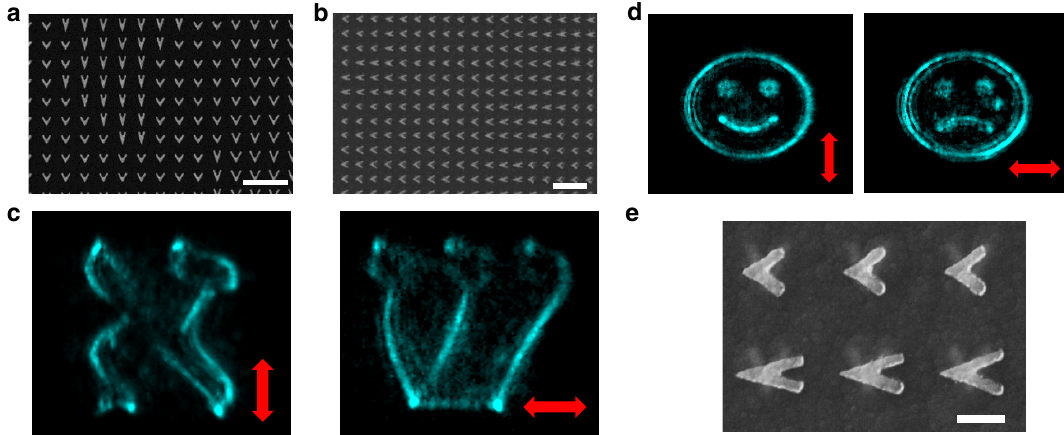
Figure 3 | Nonlinear metamaterial holograms. Scanning electron microscopy (SEM) images of the first ( a ) and the second layer ( b ) of a 3D nonlinear hologram, which projects holographic images of the Hebrew letters Alef and Shin ( c ) for vertically or horizontally polarized input beams, respectively. ( d ) Nonlinear holograms of smiley and sad faces for vertically or polarized fundamental beams respectively. ( e ) SEM image of two typical overlaid layers of nanoantennas. Scale bars, 1 m m ( a , b ), 200nm ( e